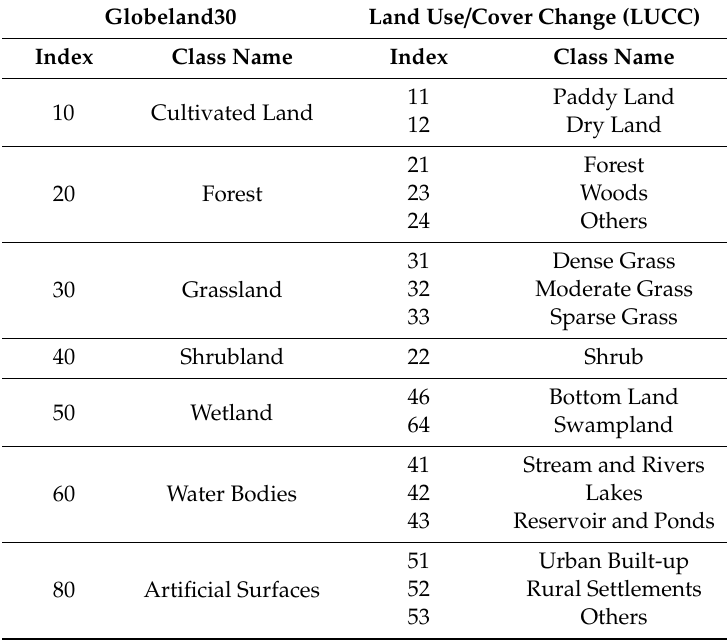
Table 1. Land cover dataset reclassification and corresponding